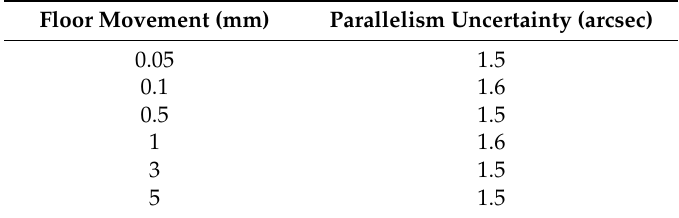
Table 1. Floor movement alignment parallelism simulation (in